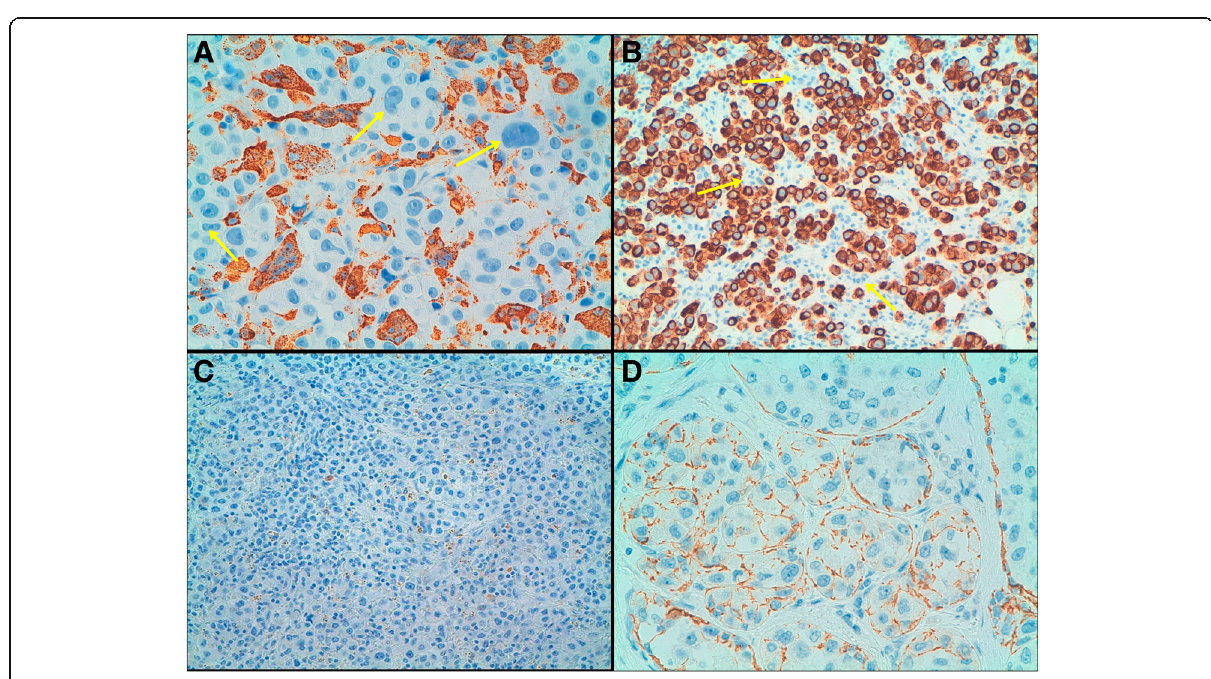
Fig. 2 Inmunohistochemistry. a Osteoclast-like giant cells were positive for CD68. In contrast, neoplastic cells were negative for CD68 (arrows). b Neoplastic cells were positive for cytokeratin (CK) AE1/AE. In contrast, Osteoclast-like giant cells were negative for CK AE1/AE3 (arrows). Both ( c ) the invasive component and ( d ) the in situ component showed complete absence of expression for